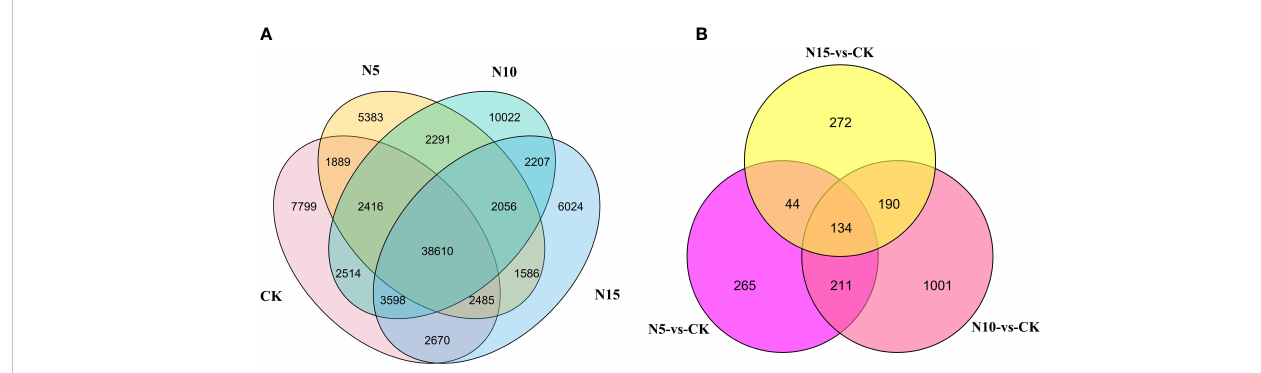
FIGURE 2 The overlap of expressed genes in each group and DEGs among three comparison groups. (A) The overlap of expressed genes in the CK, N5, N10, and N15 group. (B) The overlap of DEGs at CK-vs-N5, CK-vs-N10 and CK-vs-N15 comparison